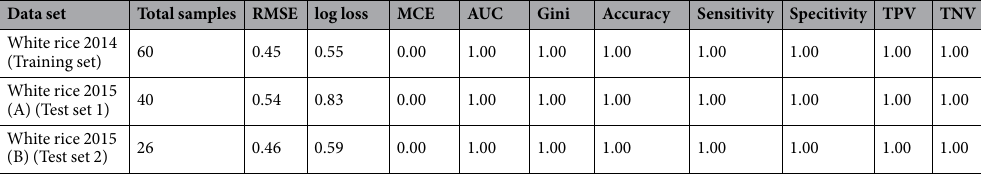
Table 3. The performance of the deep learning prediction model on training and test sets. RMSE: Root mean squared error. LogLoss: Logarithmic loss. MCE: Mean per-class error. AUC : Area under the ROC curve. Gini: Gini coefficient. TPR: True positive rate. TNR: True negative rate.